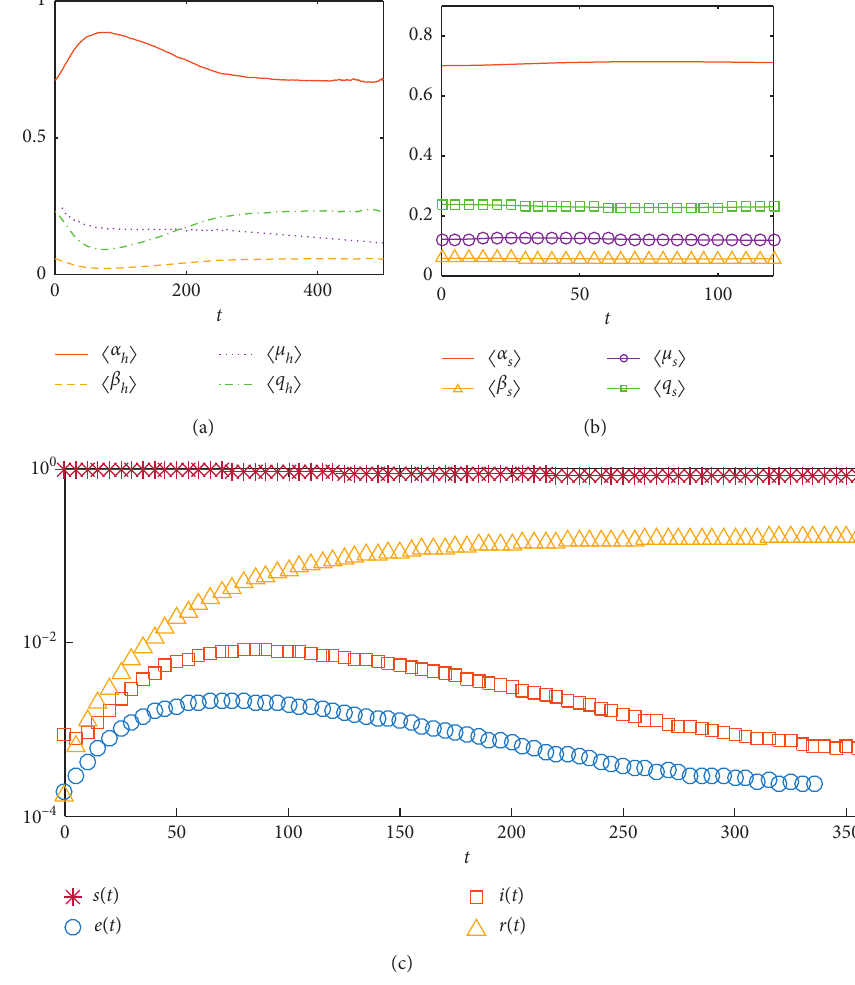
Figure 4: (a) Temporal evolution of the average values of awareness 〈 α (purple dots), and probability of resource donation 〈 q h 〉 for hub nodes. (b) The evolution of the average values of awareness 〈 α s 〉 (red line), infection rate 〈 β s 〉 (yellow triangles), recovery rate 〈 μ s 〉 (purple circles), and probability of resource donation 〈 q s 〉 (green squares) for nodes with small degree. (c) The evolution of fraction of the nodes in susceptible s ( t ) , exposed e ( t ) , infected i ( t ) , and recovered r ( t ) state, respectively. The instinctive self-awareness is α � 0 . 7 and the basic infection rate is β � 0 .